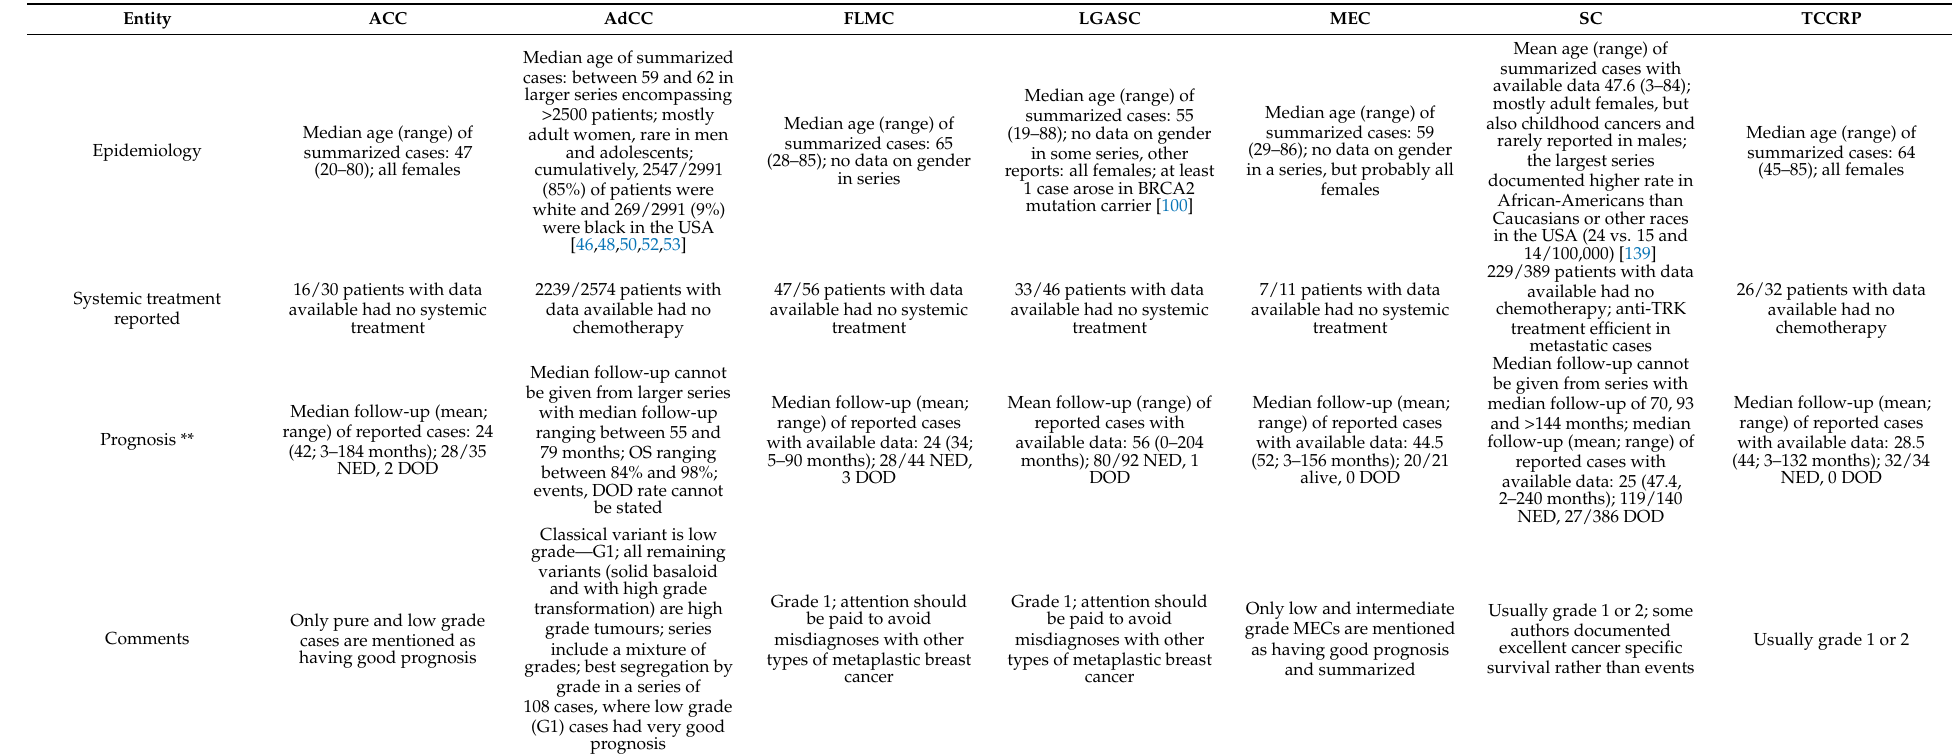
Table 1. Summary of specific data of the discussed triple negative breast cancers